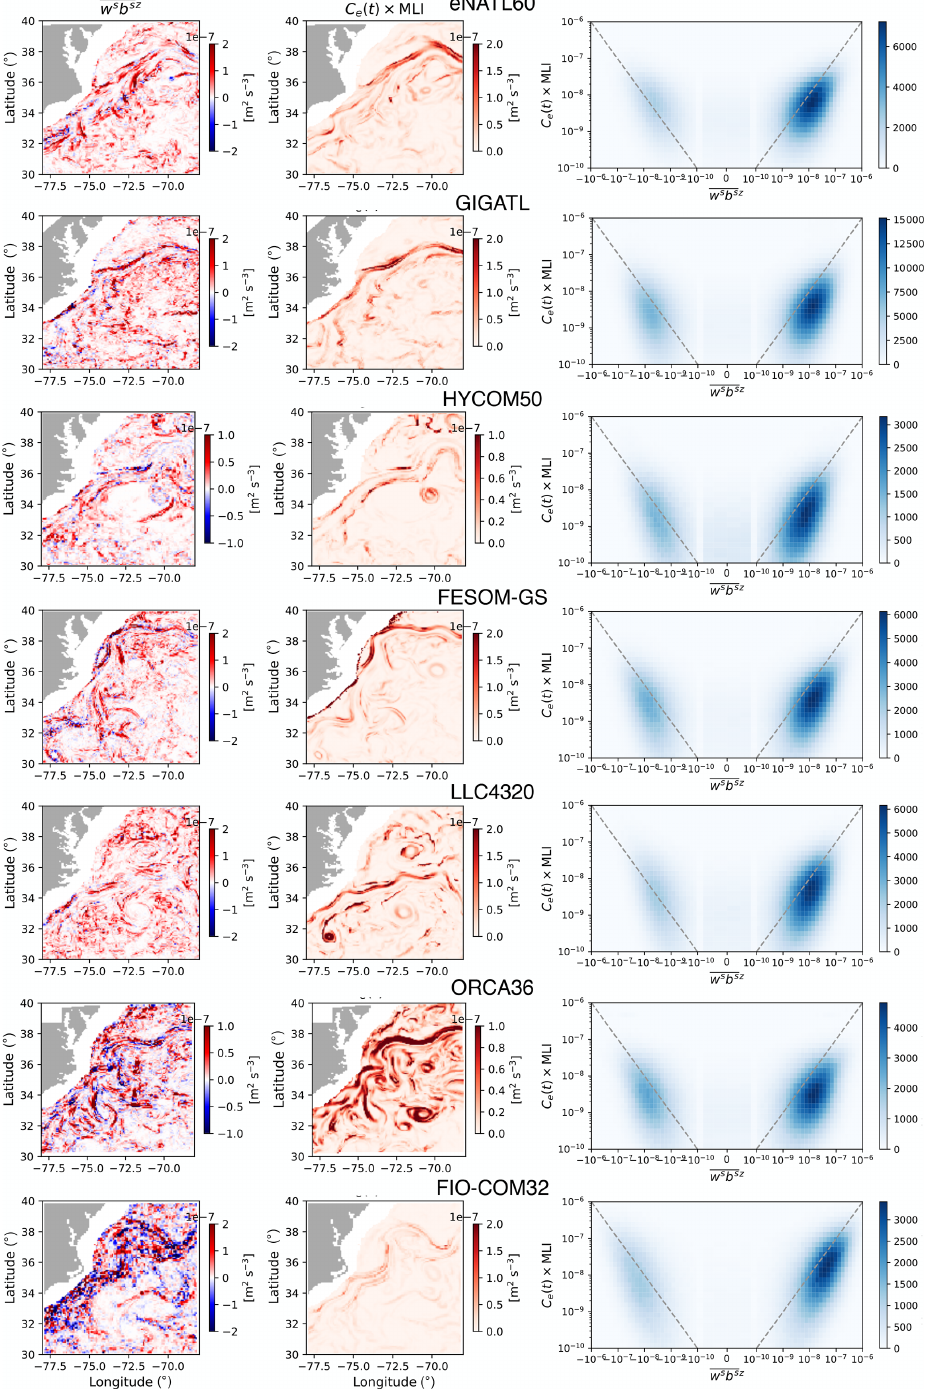
z (cid:105) Figure 7. Snapshot of (cid:104) w s b s (left column) and C e (t) × MLI (middle column) on 1 February for each model. Note that the range of the color bar differs depending on the magnitude diagnosed from each model to highlight their spatial features and comparison between the submesoscale buoyancy flux and its equivalent predicted from the parametrization per simulation. Regions with bathymetry shallower than 100m are masked out. The right column for each model shows the joint histogram of the two during the months of February to April, and the one-to-one line is shown as the grey dashed line. The histograms were computed using the xhistogram Python package (Abernathey et al.,